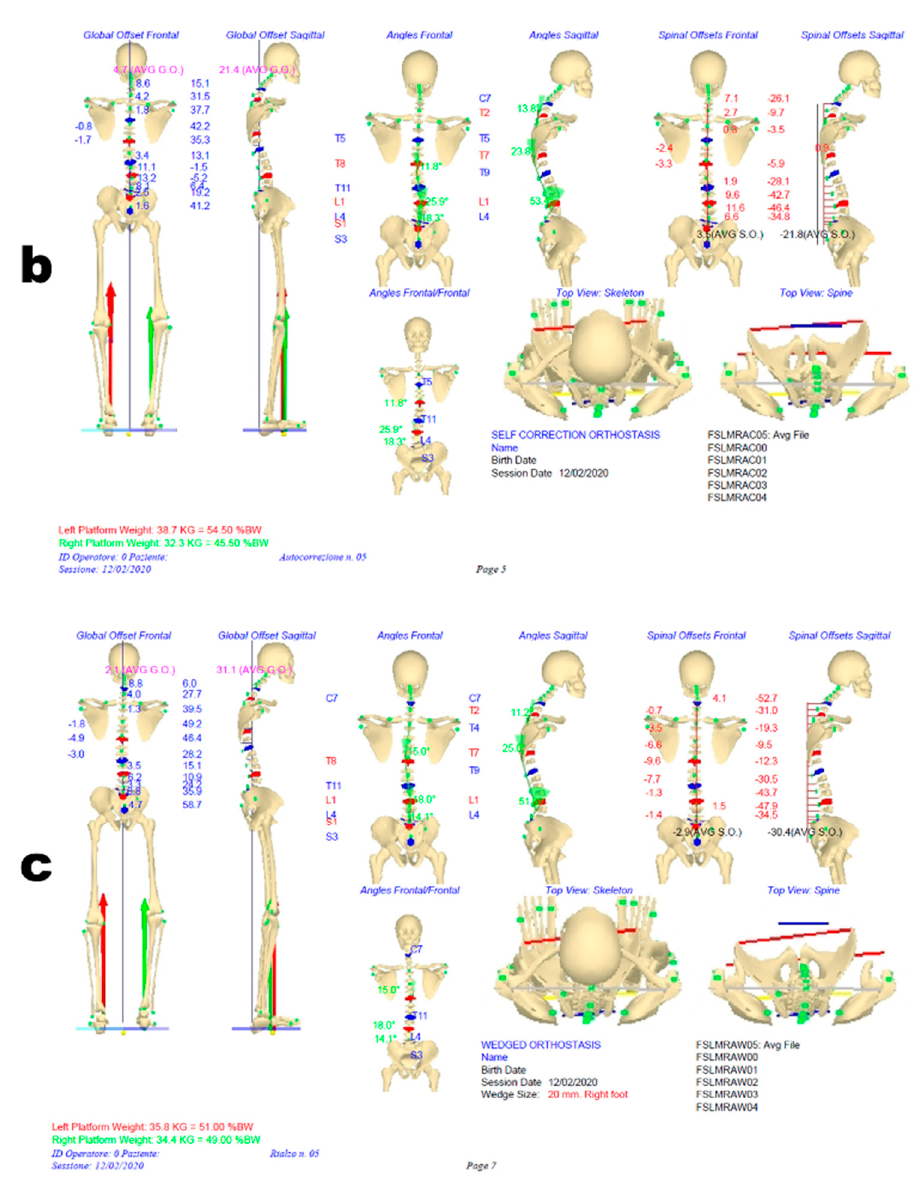
Figure 4. Standard biomechanical reports of the patient’s 3D (averaged) posture and spine shape measured in three different standing conditions: IO (panel a ), SCO (panel b ) and WCO (panel c ), respectively. The end and apical vertebrae (depicted in blue and red colours respectively), Cobb, kyphosis and lordosis angle values, and the spinal and global offset values and their averages, are automatically identified and computed (the horizontal distances in the frontal and sagittal planes of each labelled spine landmark respect to the vertical axis passing by S3 are defined as spinal offsets, while the horizontal distances in the frontal and sagittal planes of each labelled spine landmark respect to the vertical axis passing through the middle point between heels are defined as global offsets; such values are averaged to compute the average spinal and average global offsets as summarising value; negative values represent offsets on the left side in the frontal plane and forward offsets in the sagittal plane). A leg-length discrepancy (being the left leg longer than the right one) was determined in IO. It was associated with spine deformities and postural unbalancing with a lateral-leaning posture on the right side either globally or in the trunk. In WCO, it is possible to evaluate the effects induced by the LLD compensation through an underfoot wedge of 20 mm. The pelvis horizontal alignment was restored, global and spinal offsets reduced to almost zero value and spinal deformities strongly reduced in